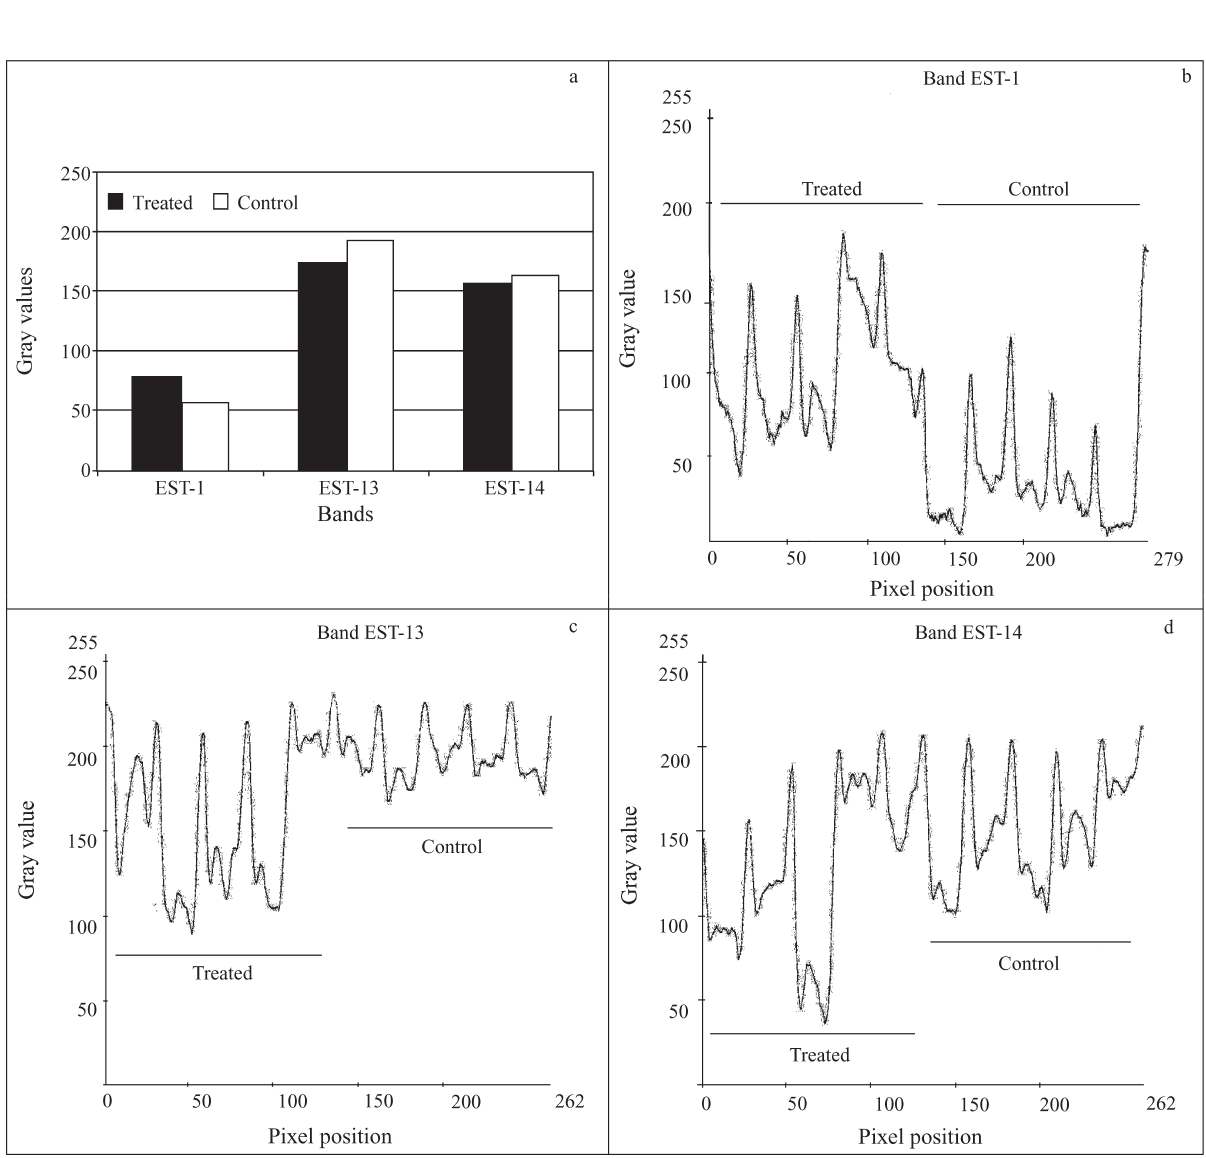
Figure 2(a-d) - (a) Distribution graph for staining degree mean values (in pixels) of esterase bands EST-1, EST-13 and EST-14, in continuous phenobar-